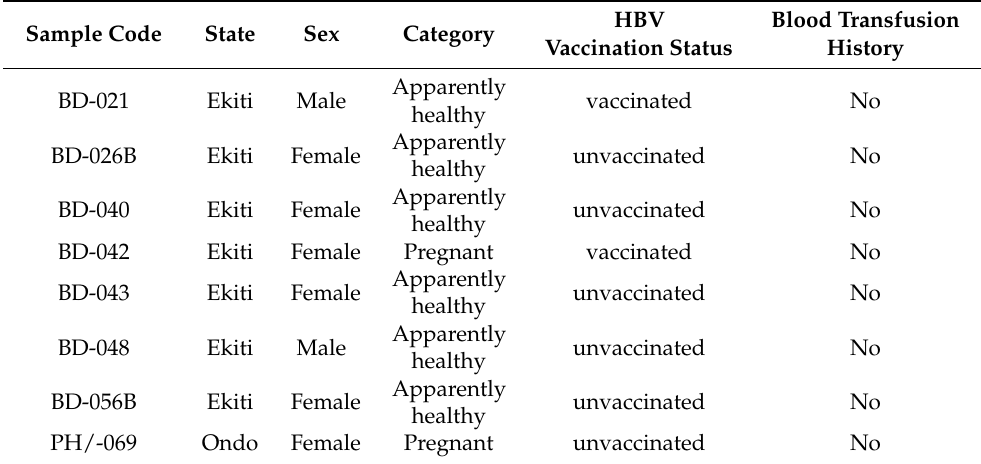
Table 3. Characteristics of subjects with immune escape mutations.